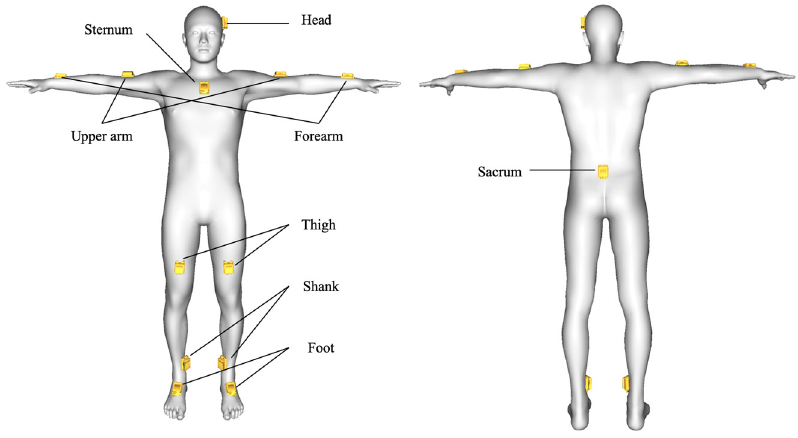
Figure 1. Attachment position of inertial measurement units.